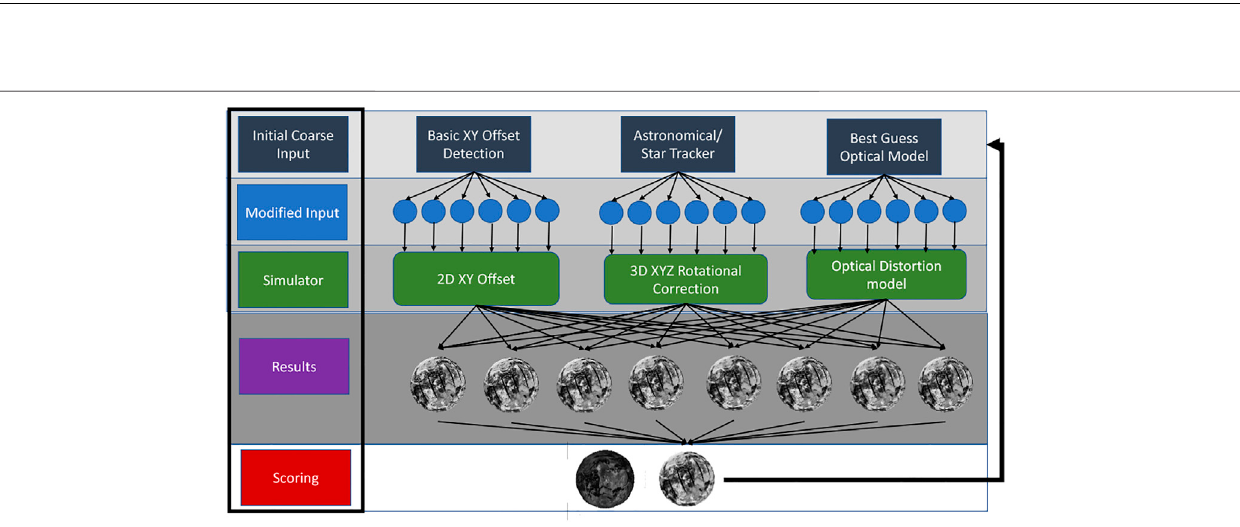
FIGURE 5 | MODIS full day image in equirectangular projection. From https://worldview.earthdata.nasa.gov/.